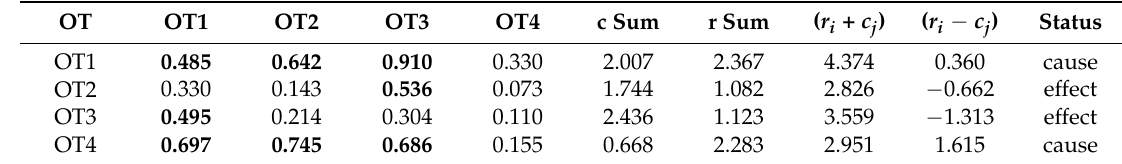
Table 10. The total relation matrix for other external FMs.